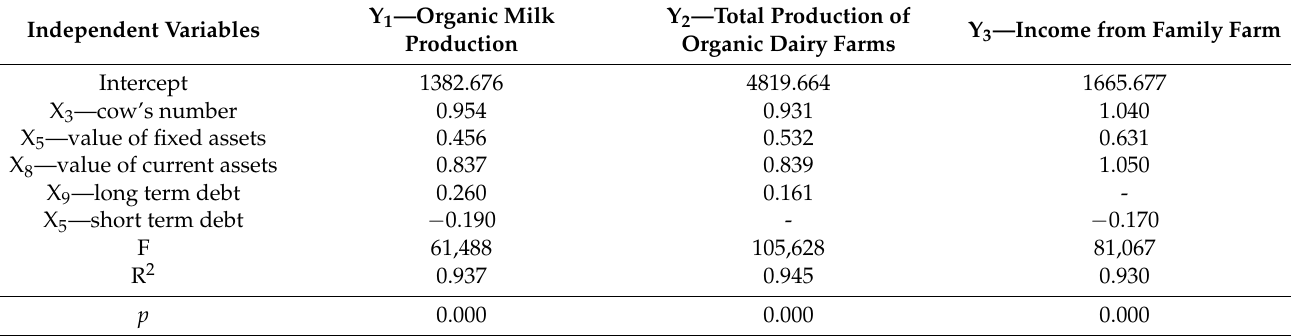
Table 11. Regression analysis of independent variables and dependent